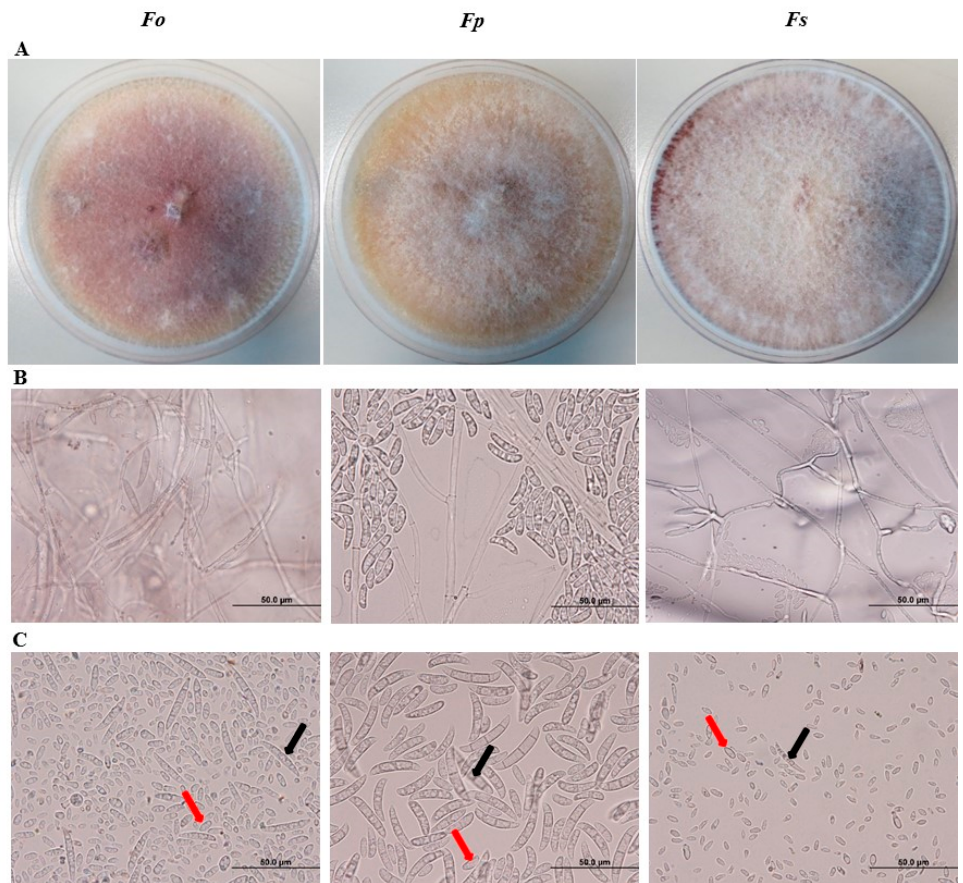
Figure 2. Morphological phenotypes mycelium and conidia of Fusarium spp. Mycelia of Fusarium spp. growing on a 10-day old PDA culture plate ( A ). Mycelium growth ( B ); and microconidia (red arrow) and macroconidia (black arrow) ( C ) of Fusarium spp. In (A–C), mycelia and conidia are from a 10-day old PDA culture. Fo , F. oxysporum ; Fp , F. proliferatum ; Fs , F. solani .